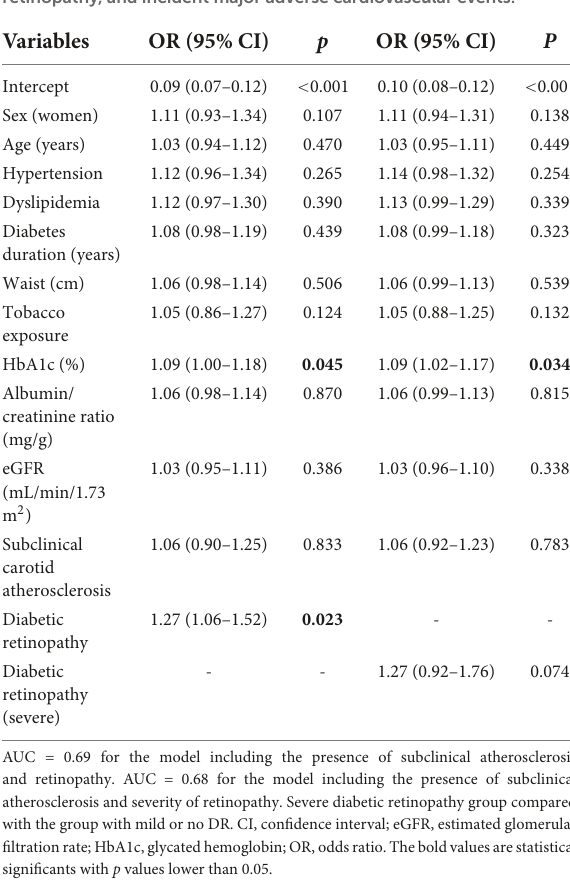
TABLE 1 Clinical characteristics of the study group according to incident cardiovascular events.